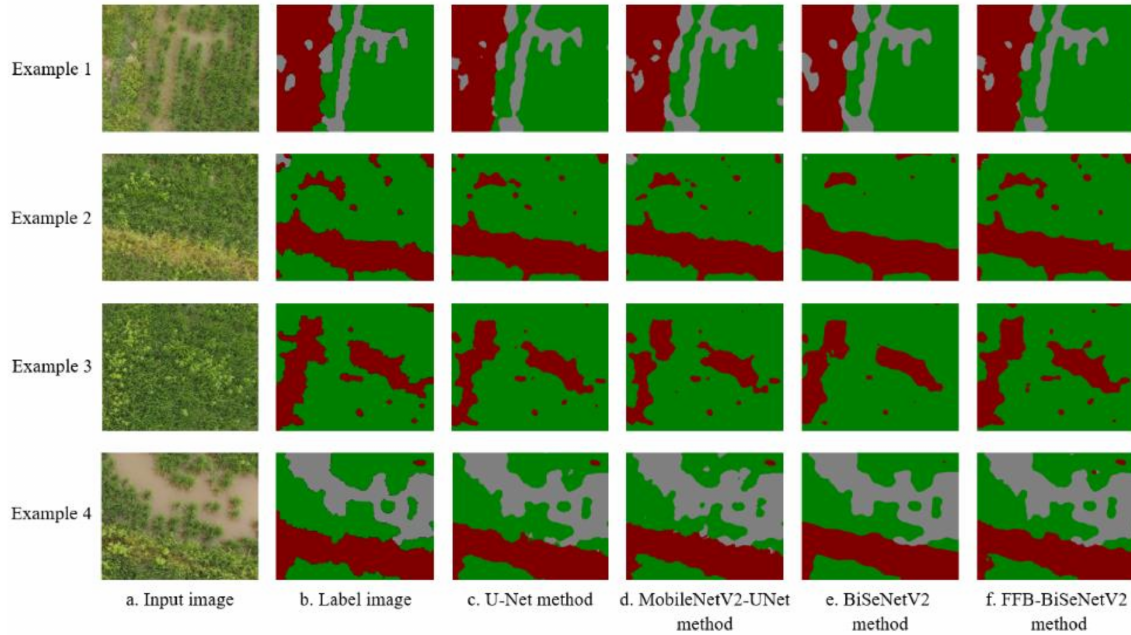
Figure 10. Segmentation results of weeds in rice fields based on low-altitude remote